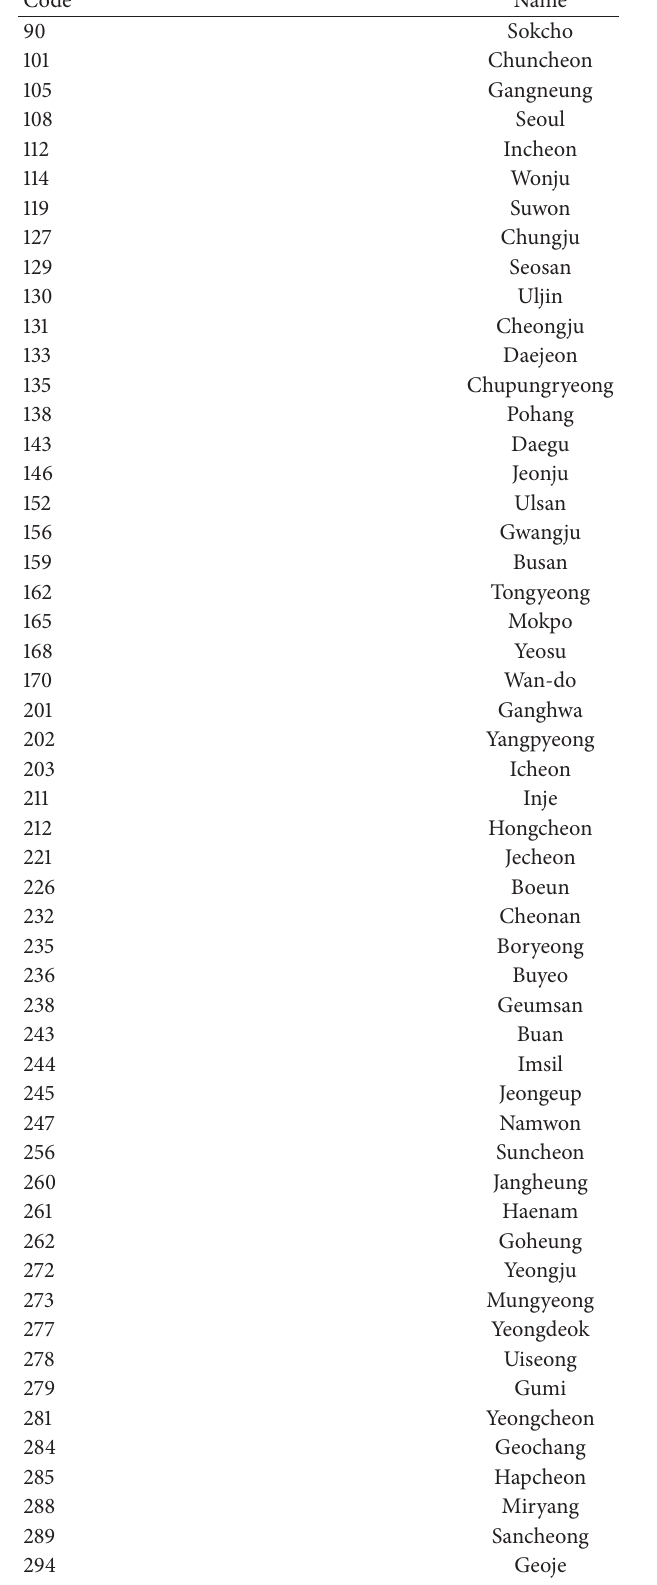
Table 2: Five major watersheds' ID and area (km 2 ) for drought